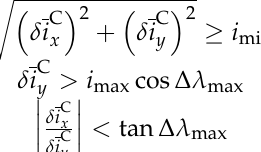
Figure 8. The NSSK in working condition one. In Figure 8, the starting point of the straight line arrow is located on the AB arc on the C2 circle, indicating that the orbital control time is the longest and remains unchanged, which is most conducive to the management of angular momentum. The direction of the straight line arrow points to the center of the circle, indicating that the SK point is in the SK zone and needs to be adjusted in real time according to the actual orbital inclination vector. The 45 ◦ arrow describes the approximate direction of the motion of the orbital inclination vector under the combined action of the perturbation force and the control force. Because the control force on the orbital inclination vector in two directions is greater than the perturbation force on it, the working condition one will only enter the normal working condition in one